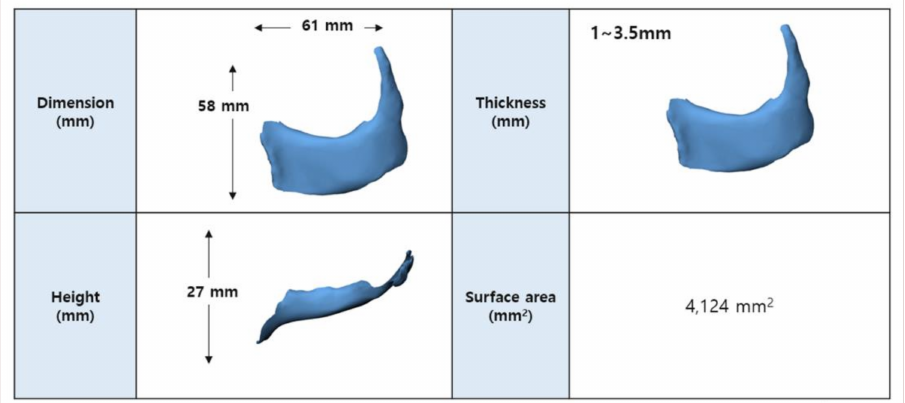
Figure 1. Design of patient-specific PCL/ β -TCP scaffold in patient #1. The implant was three- dimensionally designed using 3D modeling software based on the mirror imaging of a contralateral normal zygomatico-maxillary structure.